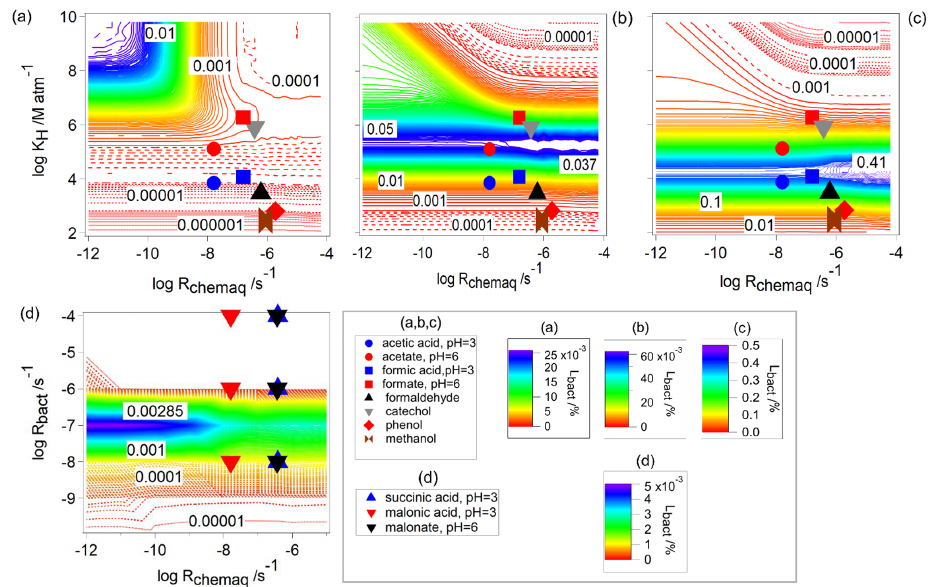
Figure 10. (a–c) L bact for water-soluble organic gases. The contour plots are identical to Fig. 7a–c. Symbols show combinations of R chemaq and K H for specific compounds (Table 1). For all simulations, R chemgas = 10 − 6 s − 1 ; (a) R bact = 10 − 8 s − 1 , (b) R bact = 10 − 6 s − 1 , (c) R bact = 10 − 4 s − 1 , and (d) L bact for CCN-derived organics (Table 1). The contour plot is identical to Fig. 8b. Note that R chemaq and R bact for succinate (pH = 6) are nearly identical to the values for succinic acid (pH = 3) and were therefore omitted from the